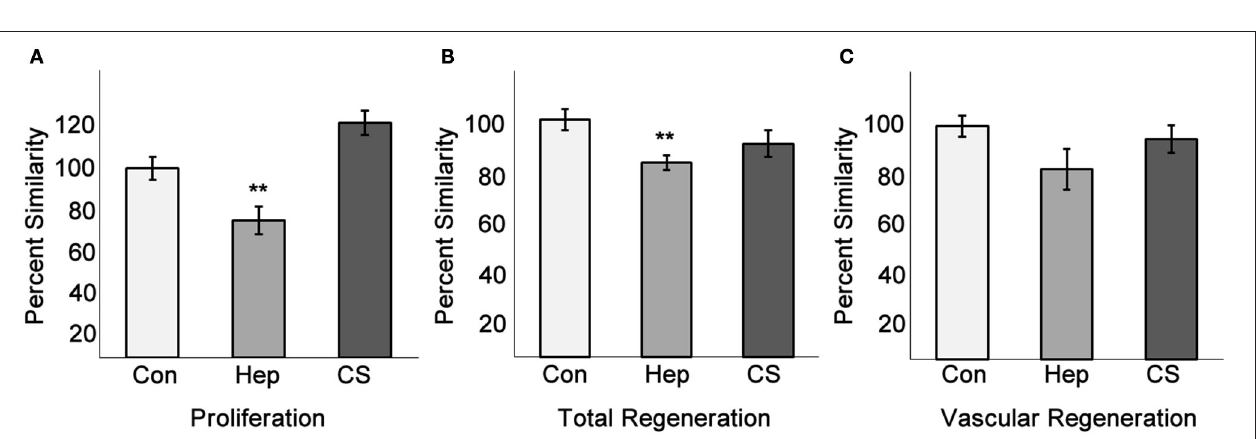
FIGURE 6 | Heparin decreases vascular regeneration. Representative confocal microscopy images of 4 dpa Tg(Fli1:EGFP) fins. Fin rays 3 and 4 of one side of a fin (noted with asterisks) were injected at 3 dpa with either with phenol red (Control), chondroitin sulfate, or heparin, and the other side was left uninjected. A slight decrease in vascular outgrowth and a delay in central artery and vein regeneration are observed in fin rays injected with heparin. Images are representative of three independent experiments with at least three fish per experimental group. Scale bars = 200 µ m.